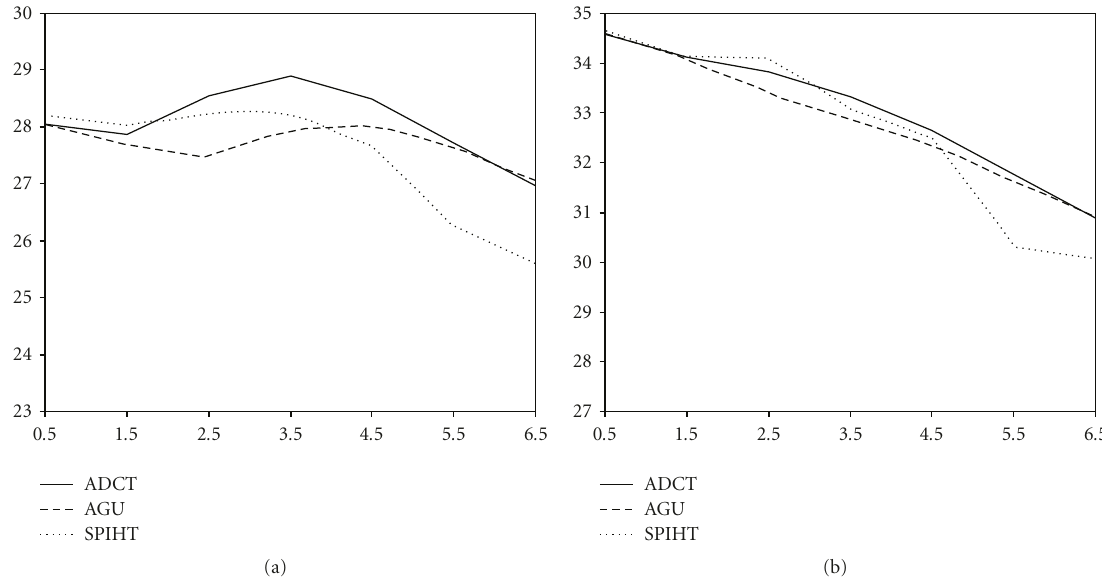
Figure 9: Dependencies of PSNR-HVS (a) and WSNR (b) on b for di ff erent coders, σ 2 = 100, image Barbara.